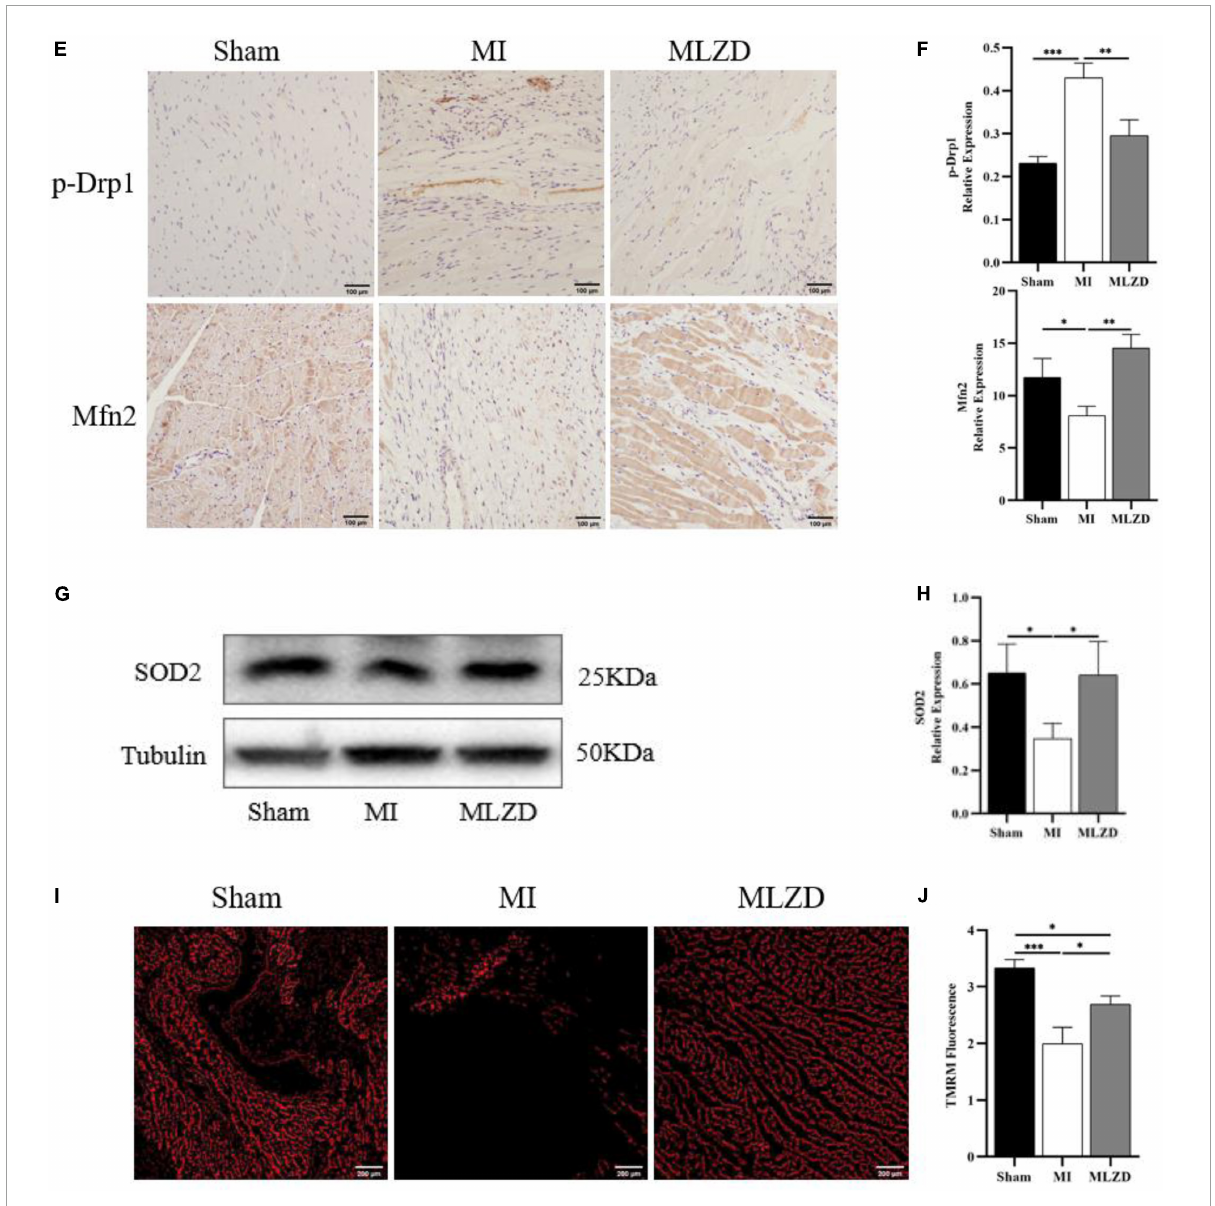
FIGURE6 Modified Linggui Zhugan Decoction (MLZD) repairs mitochondrial damage. (A) The representative transmission electron microscope (TEM) images of mitochondria in the hearts at a magnification of 8.0k and 3.0k, respectively (Scale bar = 0.5 or 1 µ m). (B) The mitochondrial number changes and the average mitochondrial area ( µ m 2 ) under TEM in heart tissue, n = 20 visual fields (5 visual fields per rat, 4 rats per group). (C,D) Western blot analyses of the expression of p-Drp1, Mfn2, PGC-1 α , and PPAR- γ in cardiac tissue. The widths of the images have been compressed at a ratio of 1:0.6. n = 4 per group. (E,F) Relative expression of p-Drp1 and Mfn2 in heart detected through immunohistochemical analyses, n = 3 per group, scale bar = 100 µ m. (G,H) Western blot analyses of SOD2 expression in the heart. The widths of the images have been compressed at a ratio of 1:0.6. n = 4 per group. (I) Representative images of TMRM staining captured via fluorescent microscopy, scale bar = 200 µ m. (J) Quantitation of fluorescence intensity in different groups, n = 3 per group. Data are mean ± standard deviation ( x ± s); ∗ P < 0.05, ∗∗ P < 0.01, ∗∗∗ P < 0.001, ∗∗∗∗ P <